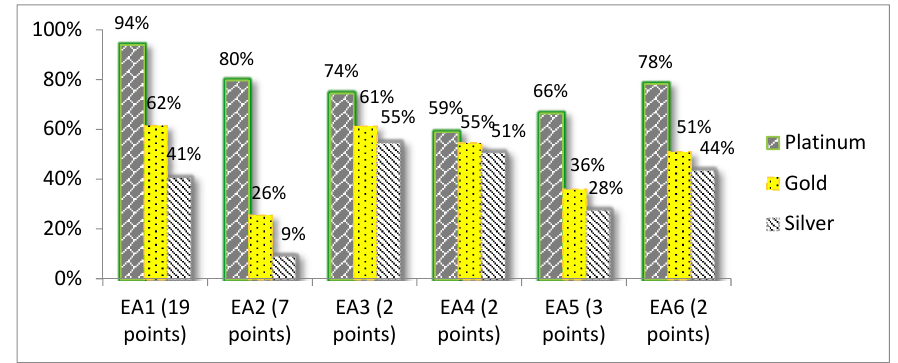
Figure 1. Performance of Energy and Atmosphere credits with respect to certification levels.